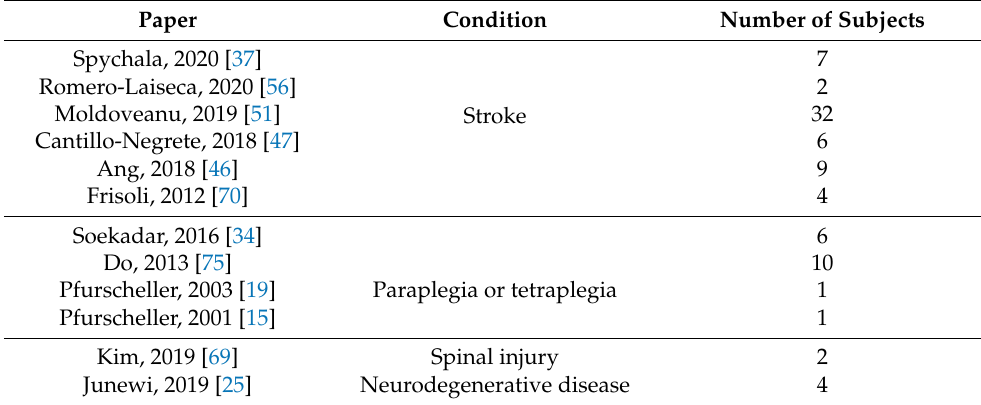
Table 3. A summary of the papers that included patients and the number of subjects considered.